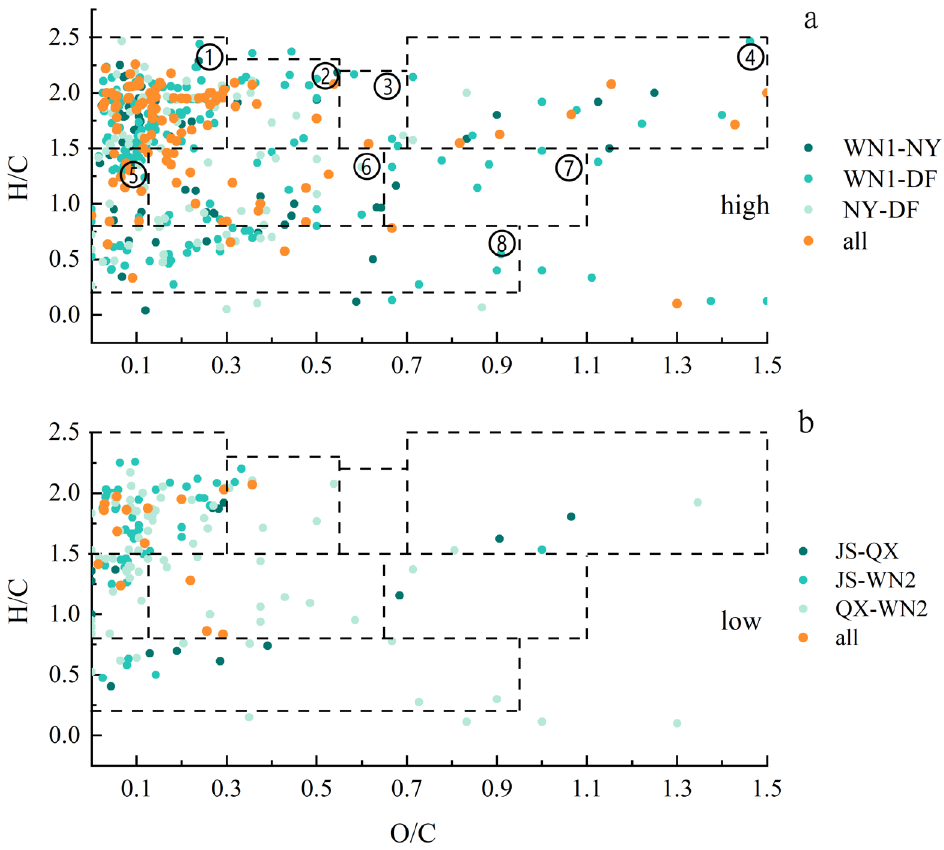
Figure 6. Van Krevelen diagrams of common SOM formulas. ( a ) Common formulas in high-quality soils. ( b ) Common formulas in low-quality soils. Different colors indicate common fractions between two or three samples. Different numbers on dotted box in high represent different compounds that are appropriate for both figures: ① Lipids, ② Proteins, ③ Amino Sugars, ④ Carbohydrates, ⑤ Unsaturated hydrocarbons, ⑥ Lignin, ⑦ Tannins, ⑧ Condensed